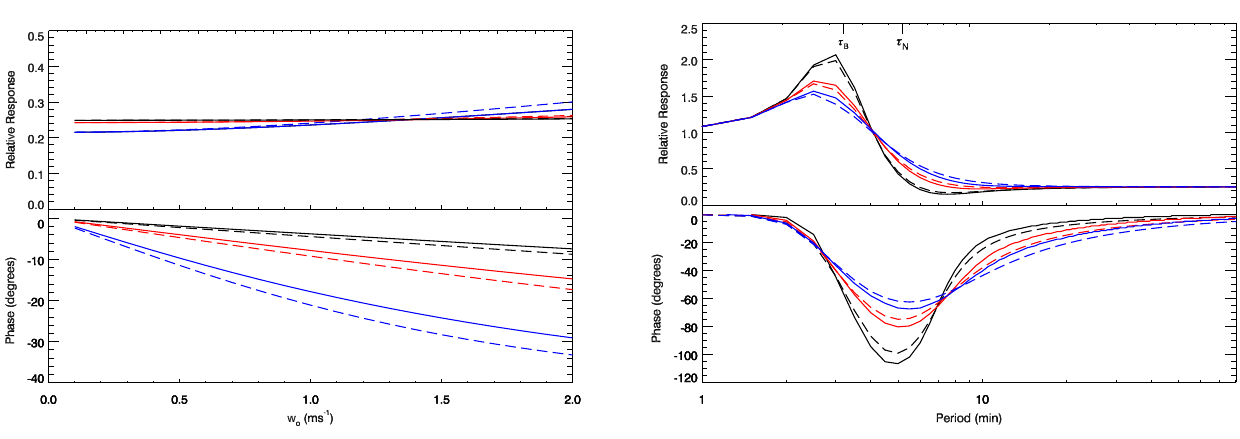
Fig. 3. As in Fig. 2, but with the SPB response as a function of wave period for waves with vertical velocity amplitudes of w o equal to 0.5 (black), 1.0 (red) and 1.5ms − 1 (blue). The symbols τ B and τ N in- dicate the periods corresponding to the neutral buoyancy oscillation ( ω B ) and Brunt–Väisälä ( N ) frequencies,